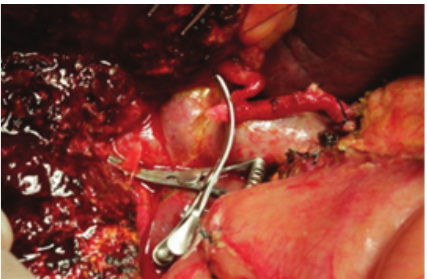
Figure 1: The right hepatic artery was affected. Dissect the affected hepatic artery for en bloc resection.